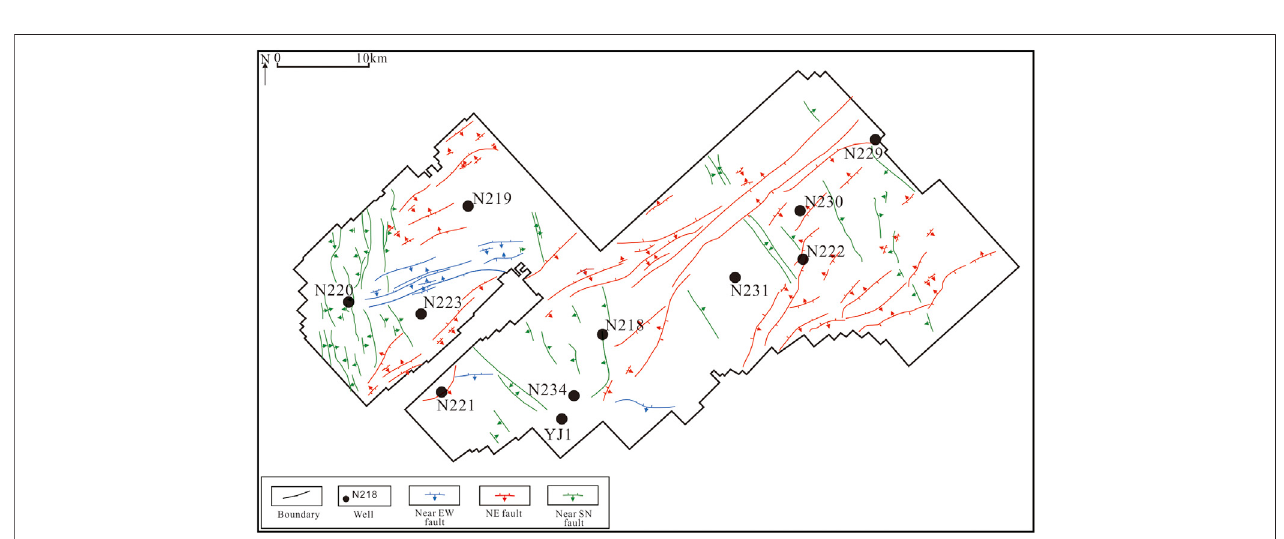
FIGURE 8 | Structural outline of the Longmaxi Formation in the Yanjin – Junlian area (seismic interpretation results).